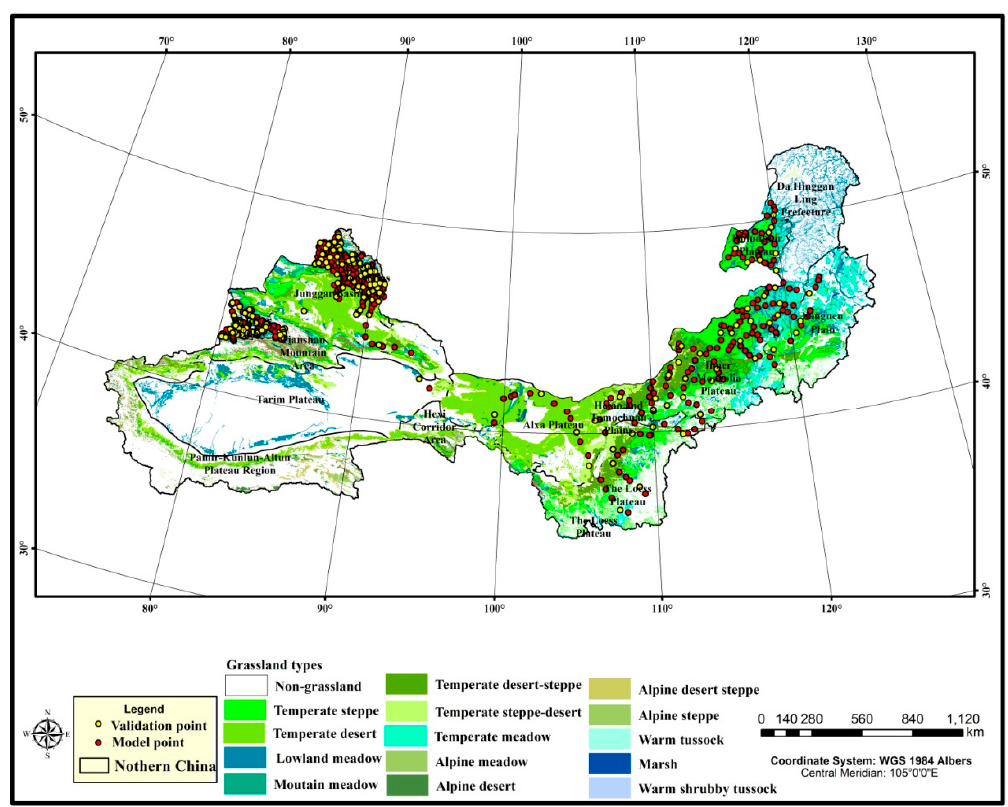
Figure 1. Spatial distribution of the northern grassland in China and distribution of survey sample sites.